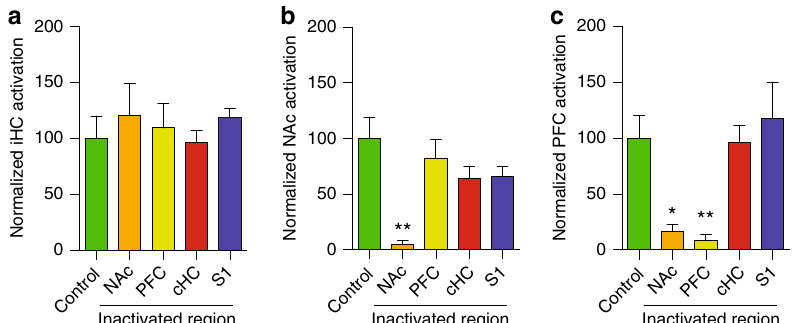
Fig. 6 Group analysis of network inactivation. The number of nodes in the relevant networks is quanti fi ed after LTP induction with or without targeted inactivation and normalized relative to the control, fully active, condition. a Proportion of nodes recruited by perforant pathway stimulation in the ipsilateral HC under control conditions (100%) and after inactivation of the NAc, PFC, contralateral HC (cHC), and S1, as indicated in the x -axis. Analysis of variance across groups demonstrates no statistical differences (ANOVA, F 4,24 = 0.3641, p = 0.8317). b Proportion of nodes recruited in the NAc following targeted inactivation in the structures indicated in the x -axis. ANOVA demonstrates statistically signi fi cant differences between groups ( F 4,24 = 4.841, p = 0.0053) and post-hoc Bonferroni test fi nds the only signi fi cant difference in NAc recruitment when the NAc is directly inactivated ( p < 0.01), as expected from the experimental manipulation, but no effect under PFC, cHC, or S1 inactivation. c Proportion of nodes recruited in the PFC following targeted inactivation in the structures indicated in the x -axis. ANOVA demonstrates statistically signi fi cant differences between groups ( F 4,24 = 6.416, p = 0.0012) and post-hoc Bonferroni test identi fi es strong reductions in both PFC ( p < 0.01), expected from the experimental manipulation, but also NAc ( p < 0.05), indicating